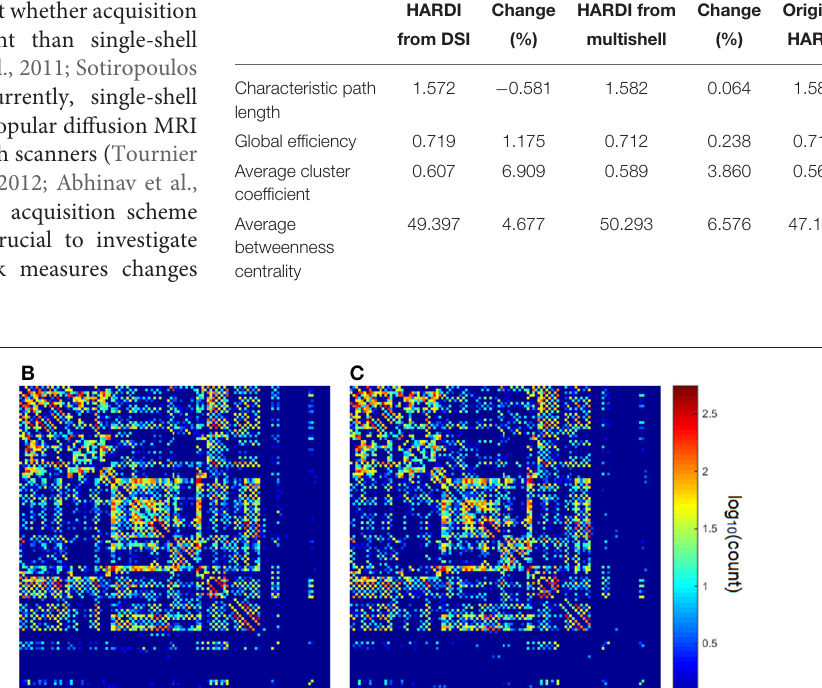
TABLE 3 | Network measures calculated from converted HARDI and original HARDI. HARDI Change HARDI from Change Original from DSI (%) HARDI Characteristic path length